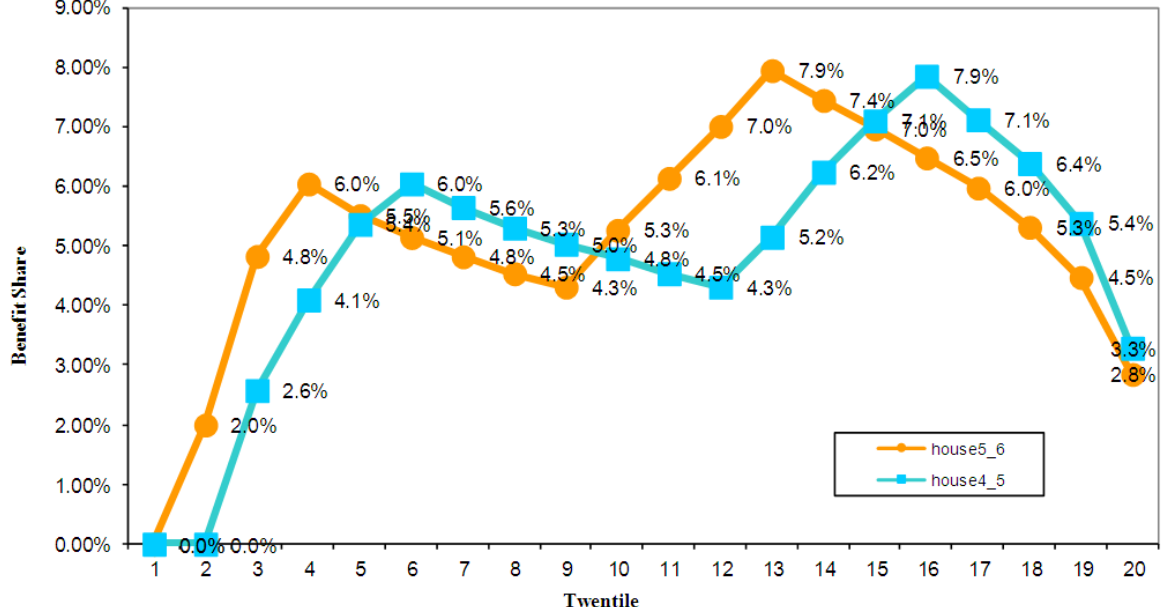
Figure 1. The Level of Benefits by Twentiles (as a share of annual water expenditure before household